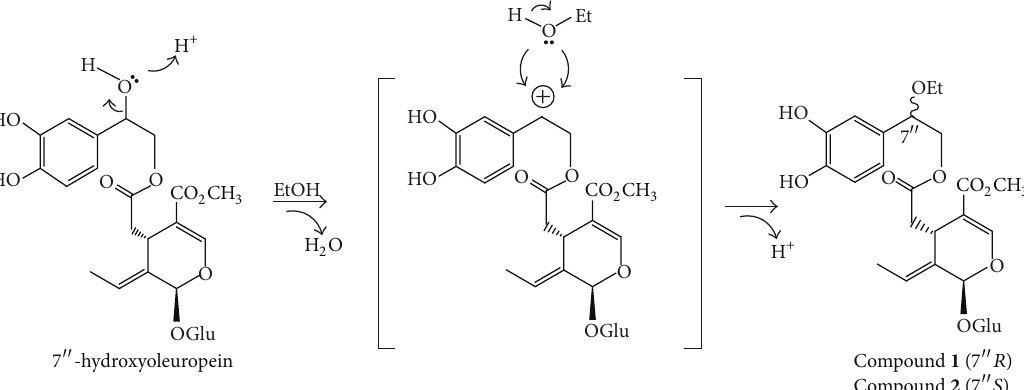
Scheme 1: Proposed reaction pathway for the conversion of the natural product 7 󸀠󸀠 -hydroxyoleuropein into the artefacts 1 and 2 during the extraction of olive wood (sample D ) with